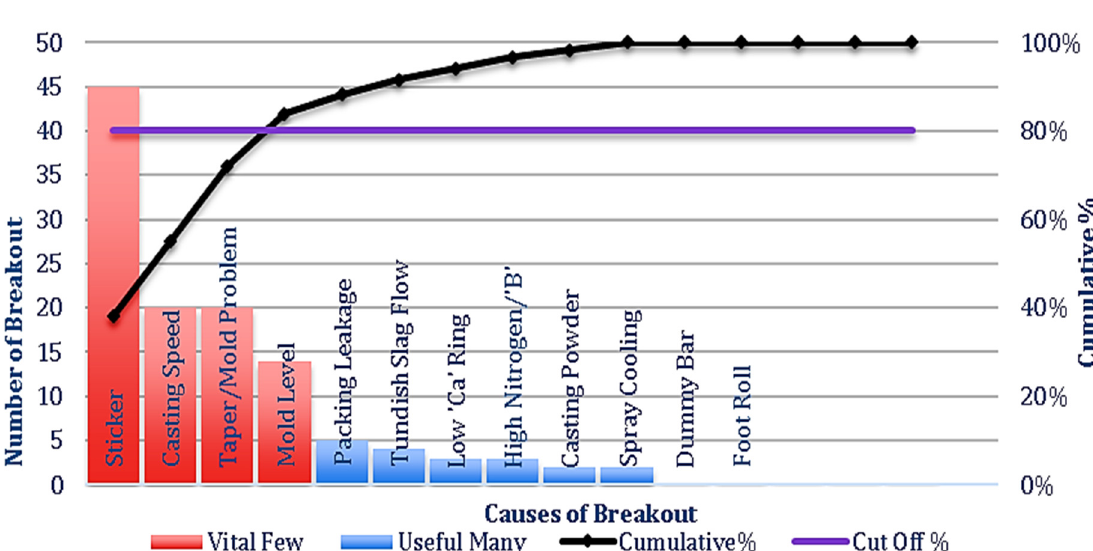
Figure 2. A schematic diagram of breakout.